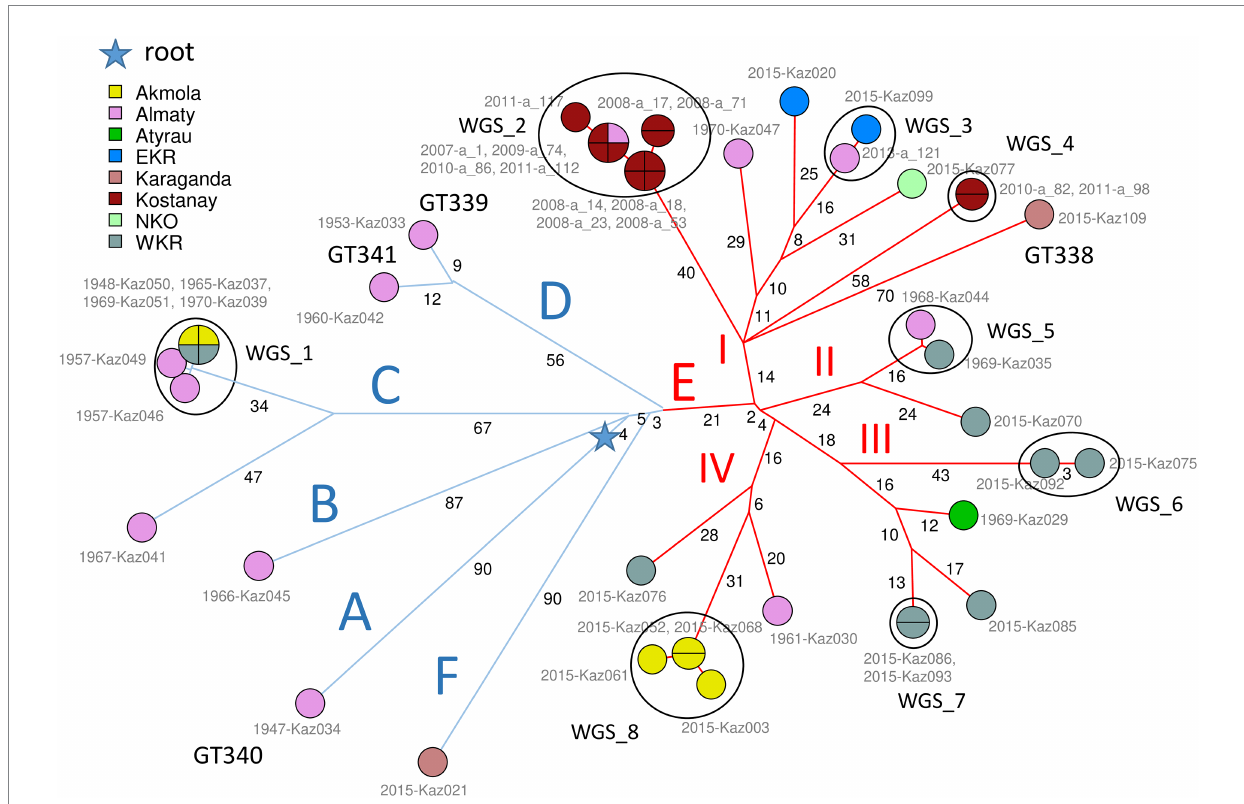
FIGURE 1 Brucella abortus subclade C1, 46 strains from Kazakhstan. Maximum parsimony tree based on core genome SNPs. 1,146 SNPs were called by mapping on genome accession GCA_000740155 ( B. abortus clade B strain Tulya). The size of the resulting tree is 1,151 SNPs (homoplasia 0.44%). Thirty-three whole-genome SNP (wgSNP) genotypes are resolved. Branch lengths of two SNPs and more are indicated by black numbers. Strains are labeled in gray with collection year and strain Ids and colored according to region of origin as indicated. The MLVA11 genotype is indicated for new lineages distinct from GT72 (GT338 to GT341). The blue star indicates the root of the phylogeny (branching point toward B. melitensis type strain 16 M used as outgroup). From the blue star, early splits define six branches, labeled A to F. Blue branches A to D are defined by a few ancient strains isolated between 1947 and 1970. Blue branch F is defined by one recent strain, KAZ021 isolated in 2015. Red branch E with 34 strains (24 wgSNP genotypes) is remarkable by its diversity (24 wgSNP genotypes) and high number of associated strains (34 out of 46). It contains all but one of the recent strains (isolated in 2007–2015) together with five ancient strains. The E branch is structured into four subbranches labeled I to IV in red. Strains closely related or coincident in terms of wgSNP genotype define eight clusters labeled WGS_1 to